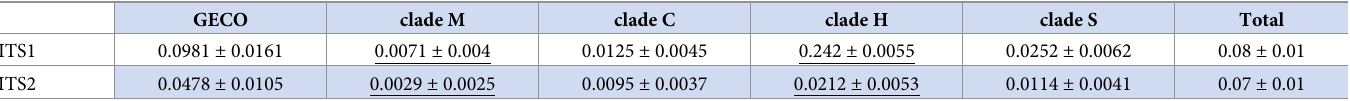
Table 3. Within group mean